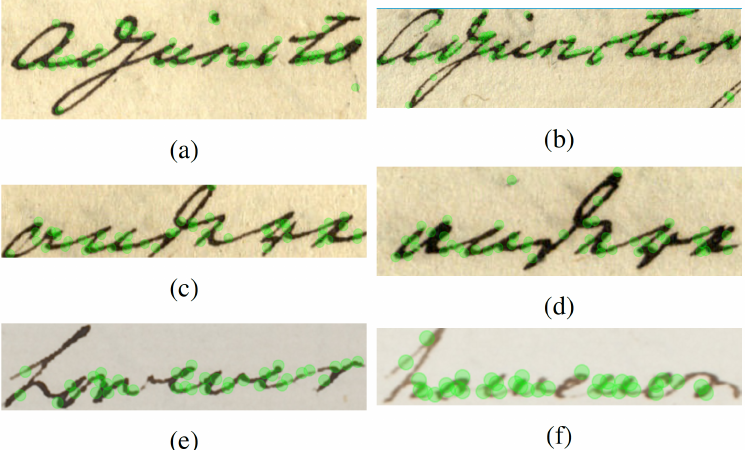
Figure 4. Presentation of the Dolf’s location for various handwritten words: ( a ) ‘adjuncto’; ( b ) ‘ad- junctur’; ( c , d ) ‘andere’; ( e , f ) ‘however’.